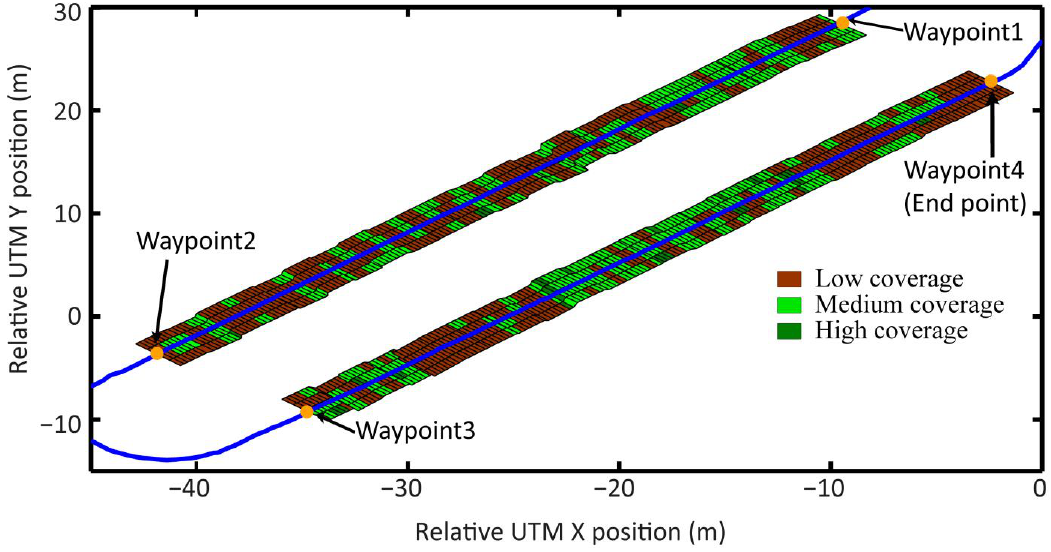
Figure 25. Resulting map of the burner’s actuation based on the original weed coverage matrices and the delays associated with the ignition and extinction of the